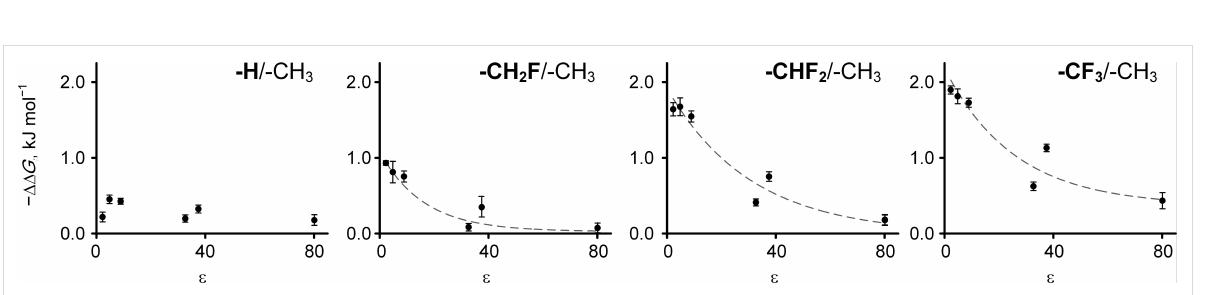
Figure 4: Enhancement of the trans/cis thermodynamic preferences in the ester models as a function of the solvent dielectric constant, ε . The trans/ cis ratios were determined from the 1 H and 19 F NMR spectra at 298 K. Solvent set: C 6 D 6 , CDCl 3 , CD 2 Cl 2 , CD 3 OD, CD 3 CN, D 2 O. For details see Table S1 in Supporting Information File